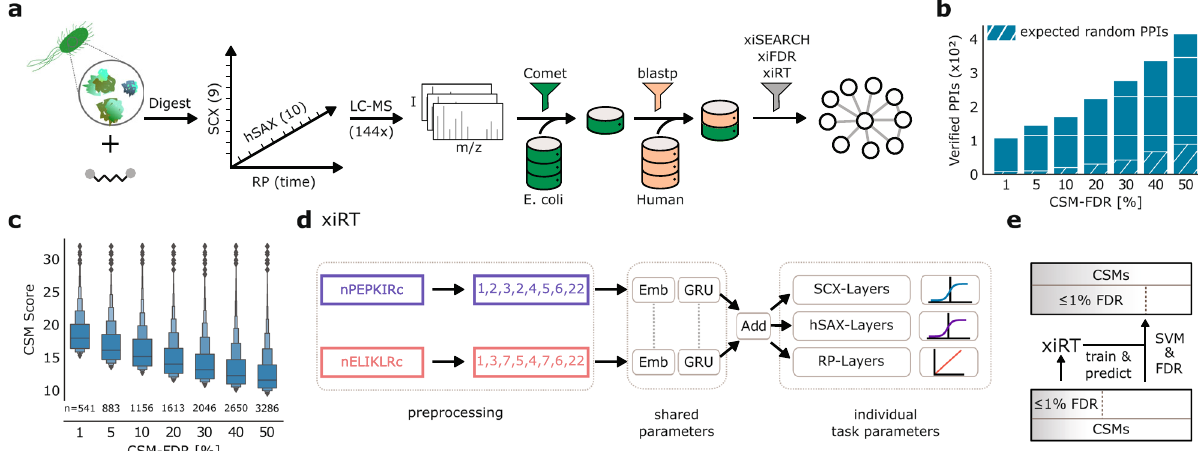
Fig. 1 Work fl ow overview. a Experimental and data analysis work fl ow. The soluble high-molecular-weight proteome of E. coli lysate was crosslinked and the digest sequentially fractionated by strong-cation exchange chromatography (SCX) (9 fractions collected), hydrophilic strong-anion exchange chromatography (hSAX) (10 pools collected), and fi nally by reversed-phase chromatography (RP) coupled to the MS. The protein database for the crosslink search was created by a linear peptide search with Comet and a sequence-based fi lter using BLAST. For each E. coli protein in the fi nal database (green) a human protein was added as a control (pale orange). b Potential for false-negative PPI identi fi cations. Veri fi ed PPIs are estimated from matches to the STRING/APID databases. PPIs are computed based on CSM-level FDR. Estimated random hits correspond to the average number of semi-randomly drawn pairs ( fi rst protein was randomly selected from the STRING/APID database and the second protein was drawn from the FASTA fi le). Gained PPIs accentuate the additional information that is available in the data at higher FDR. c Decrease of heteromeric CSM scores based on spectral evidence with increasing CSM-FDR. Boxenplot shows the median and 50% of the data in the central boxes while each successive level outward represents half of the remaining data. The sample size for each FDR category is given below the boxes. d xiRT network architecture to predict multi-dimensional retention times. A crosslinked peptide is represented as two individual inputs to xiRT. xiRT uses a Siamese network architecture that shares the weights of the embedding and recurrent layers. Individual layers for the prediction tasks are added with custom activation functions (sigmoid/linear functions for fractionation/ regression tasks, respectively). e Rescoring work fl ow. The predictions from xiRT are combined with xiSCORE ’ s output to rescore CSMs using a linear support vector machine (SVM), consequently leading to more matches at constant con fi dence. Source data are provided as a Source Data fi